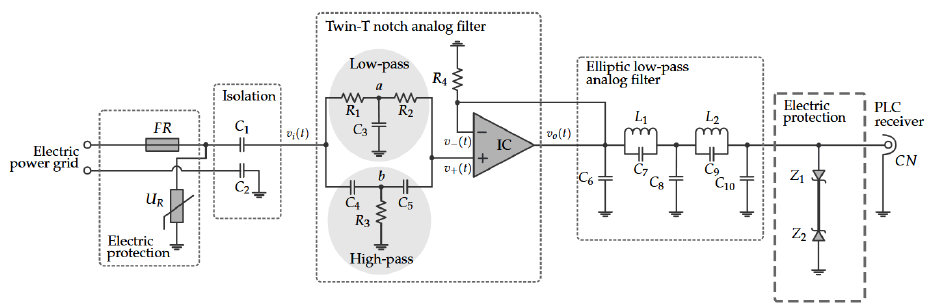
Figure 2. The scheme of the proposed NB–PLC notch coupling